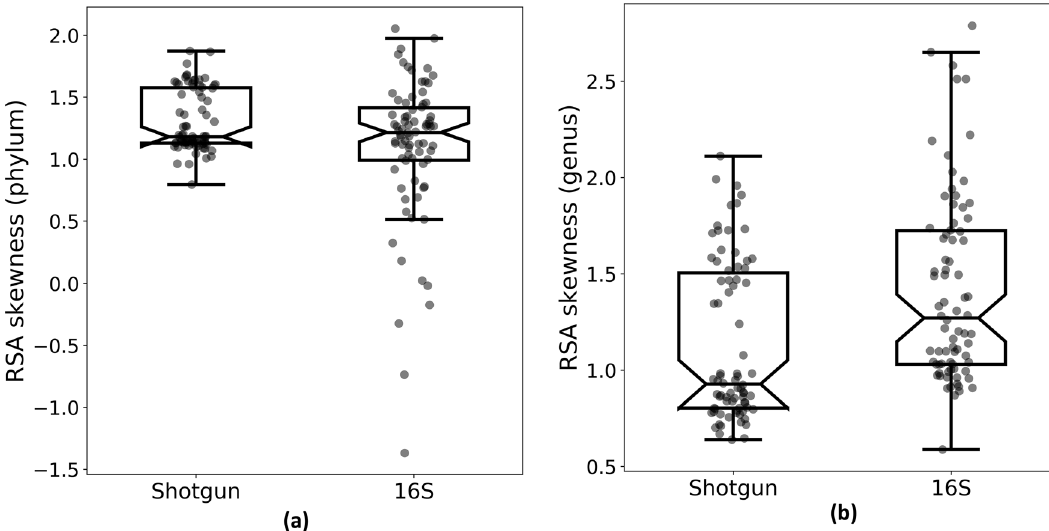
Figure 2. Box plot of the RSA skewness of bacterial communities at ( a ) phylum level and ( b ) genus level. Bacterial communities are sampled with (left) shotgun sequencing and (right) 16S positively skewed samples in the log 2 -transformed distributions, except for 16S outliers, because none of the phyla is significantly rare (Fig. 2a). On the other hand, at genus level, the two strategies display different shapes (Fig. 1c, d, Supplementary Fig. S1, S2, S3, S4). Indeed, the log 2 -transformed distributions derived by shotgun sequencing generally have a skewness closer to zero compared to those obtained by 16S, i.e. are more symmetrical (Figure 2b): a paired Student’s t-test on the skewness shows a significant difference between them (P = 8·10 –6 ). This indicates that shotgun samples are characterized by a higher sampling size. According to Preston, left-skewed shapes of the RSA can be explained as artefacts of small sample size 21,22 , since insufficient sampling of the original space produces a truncation of the left tail of the RSA, increasing its skewness. In shotgun samples, the RSA skewness at genus level is related to the total number of reads (Supplementary Fig. S5): the shotgun samples with the lowest total number of reads have the largest skewness. Specifically, Sup- plementary Figure S5 shows that shotgun samples cluster in two groups, one characterized by a low number of reads (# reads < 500,000, 28/78 samples) and a highly skewed RSA (greater than the 16S median), and one with a high total number of reads (# reads > 500,000, 50/78 samples) and a less skewed RSA. Noticeably, the high-skewness group includes all 9 samples from 1st day, all 15 crop samples from 14th day and 4 out of 18 crop samples from 35th day. The samples collected at day 1 were very poor in terms of biomass and the crop samples contained more feed residues than caecal samples, making the DNA extraction less efficient both in terms of DNA quantity and quality. For the comparative analysis we removed samples with less than 500,000 reads being characterized by a low quality. This choice was corroborated by the analysis of the rarefaction curves, showing that shotgun samples with less than 500,000 reads do not reach a plateau in terms of identified genera (Supplementary Fig. S6). All the 50 samples included in the comparative analysis have a total number of reads > 500,000 and a skewness lower than the median of 16S samples, indicating a good sampling depth. Since included samples were characterized by a high microbial load, we are confident to extend the results of the fol- lowing analyses only to samples with few contaminant DNA and low cross-contaminations. Nonetheless, we have shown that shotgun samples have a RSA similar to 16S samples when a low number of total reads is available, thus hypothesizing that in differential analyses carried on samples with a low microbial load regime, shotgun sequencing could perform similarly to 16S sequencing or even worse. For a balanced comparison, also 16S samples corresponding to the discarded shotgun samples were removed. Differential analysis for the experimental conditions. Since in many situations a metagenomic anal- ysis is used to discriminate between different experimental conditions, we compared the results of differential analysis performed on reads obtained by the two strategies. To this aim, we analysed the fold changes of genera abundances between compartments of the GI tract and between sampling times (Fig. 3 for caeca vs crop, Sup- plementary Fig. S7 for 14th vs. 35th day) common to both sequencing strategies (288 genera for caeca vs crop, and 246 for 14th vs. 45th day). Comparing the genera abundances between caeca and crop, 16S identified 108 statistically significant differences (adjusted P < 0.05 with DESeq2), while shotgun identified 256; 28 genera, corresponding to 9.7% of total common genera, were not identified as significantly different by either strategy. Among the 104 genera identified to be different between caeca and crop by both sequencing strategies, 93.3% (97/104) showed a concordant fold change. Concerning the genera with different abundance between sampling times, 16S detected 58 statistically significant changes (adjusted P < 0.05 with DESeq2), while 75 were detected by shotgun. The 80% (16/20) of the 20 genera with different abundance between the 14th and 35th day for both sequencing strategies showed a concordant fold change (see Table). The discrepancies seem to be related